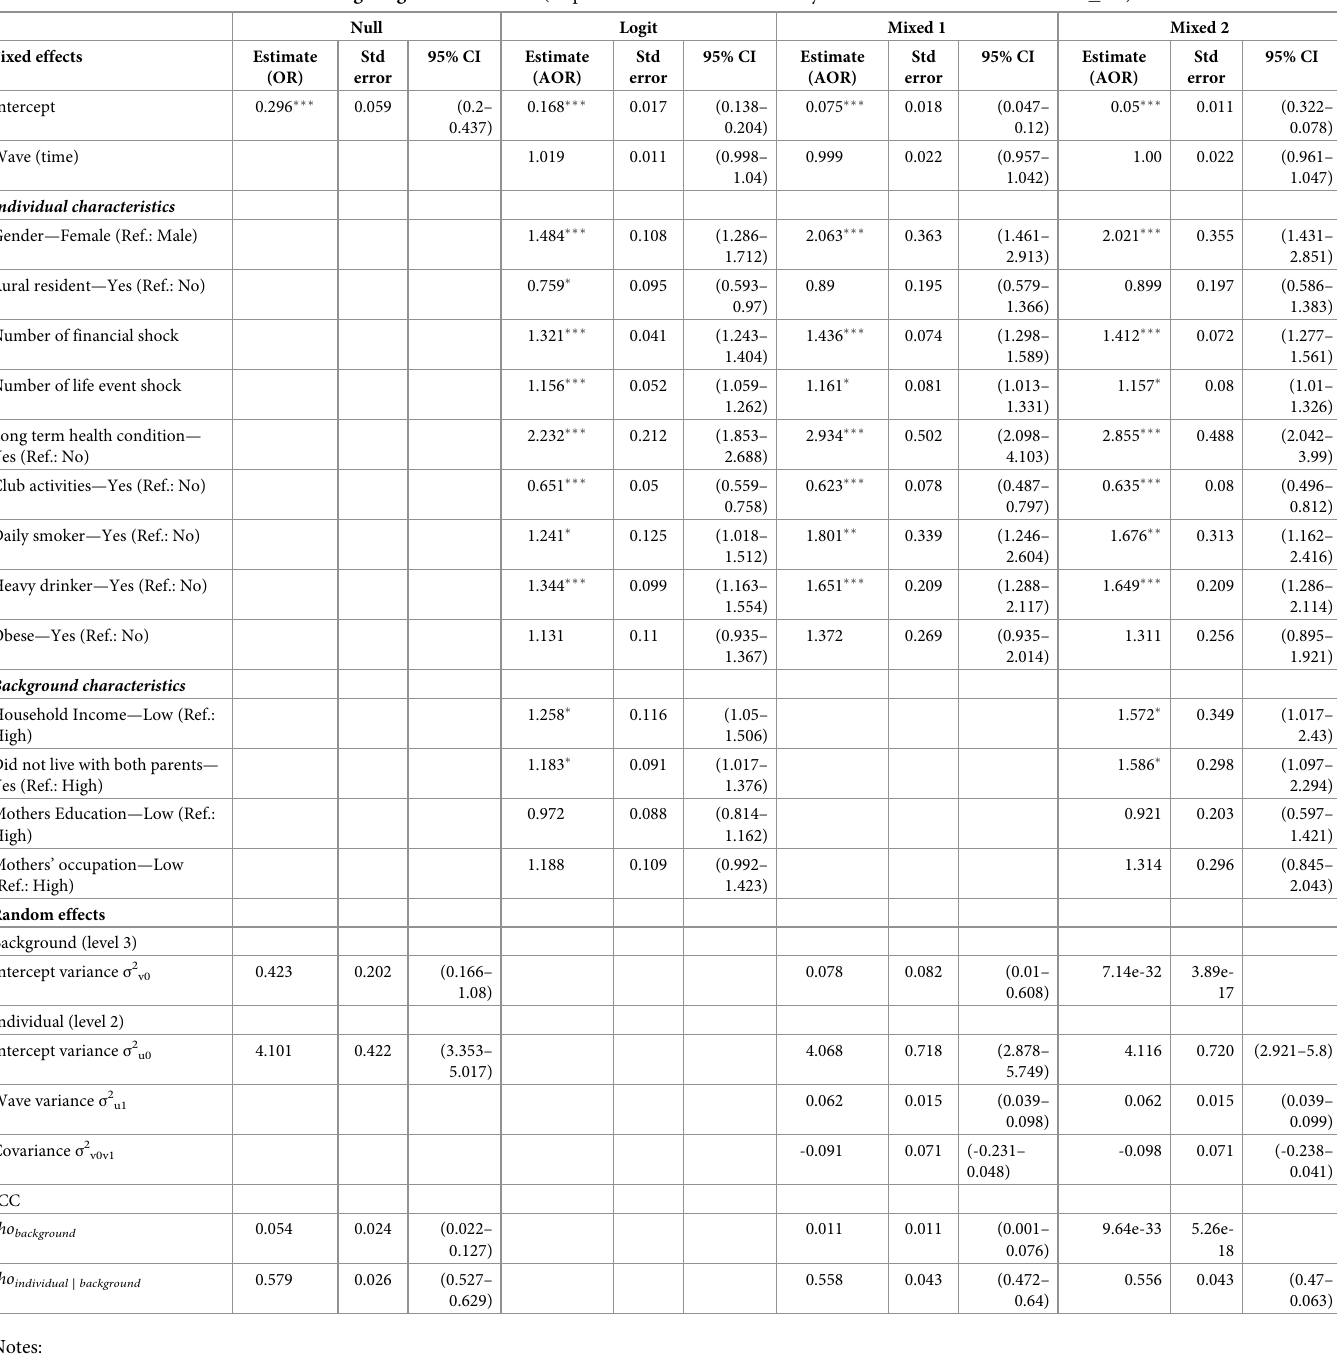
Table 3. Parameter estimates of different logit regression models. (Depedent variable: Whether likely to have mental disorder- i.e. K10 � 20). Null Logit Mixed 1 Mixed